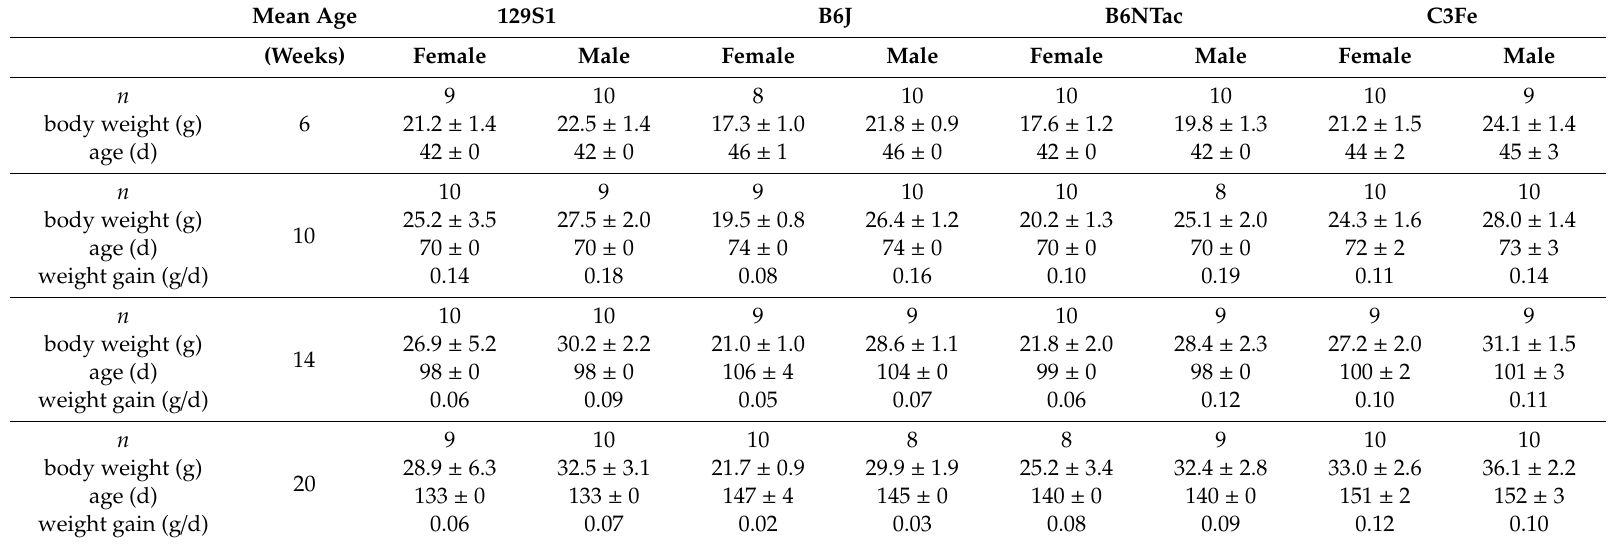
Table 1. Animal data. Mean age in weeks at blood sampling calculated from the entire